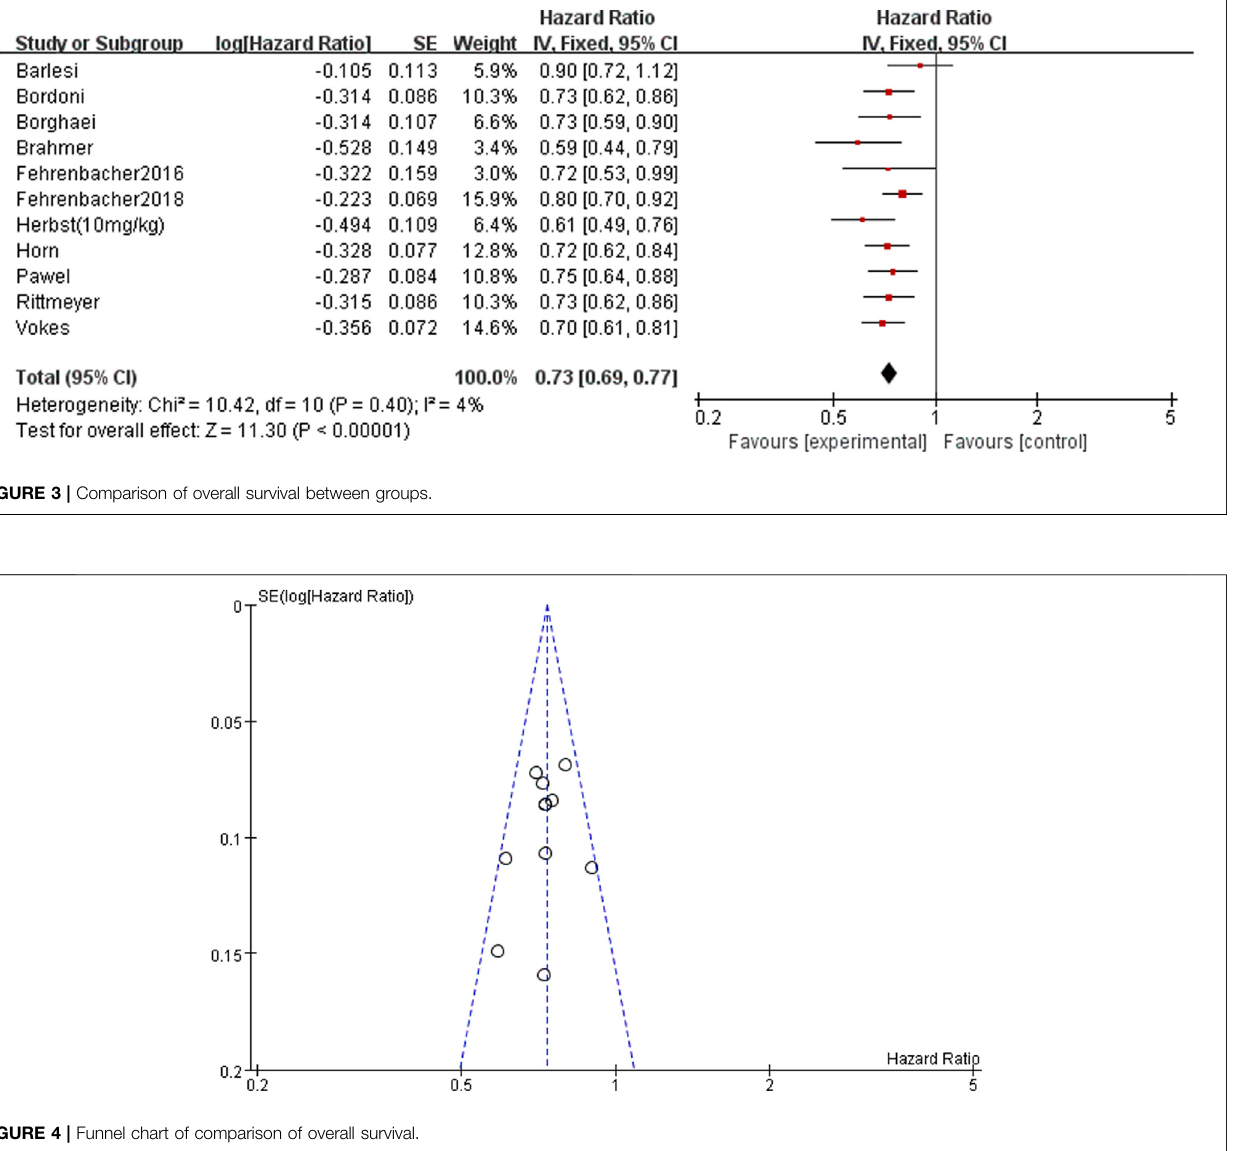
FIGURE 4 | Funnel chart of comparison of overall